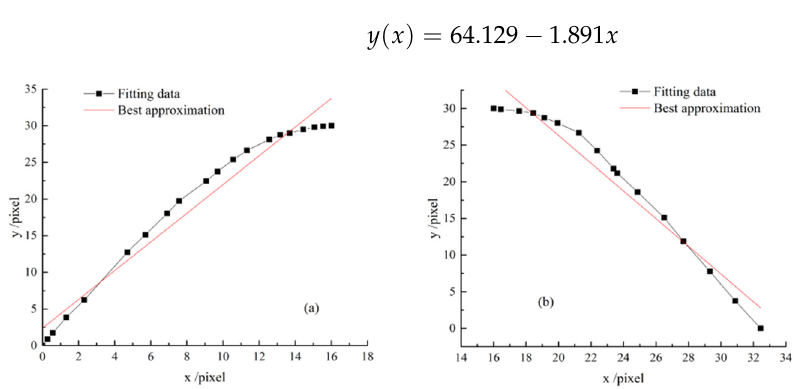
Figure 4. Fitted line of incisor lobe: ( a ) rising part; and ( b ) falling part.